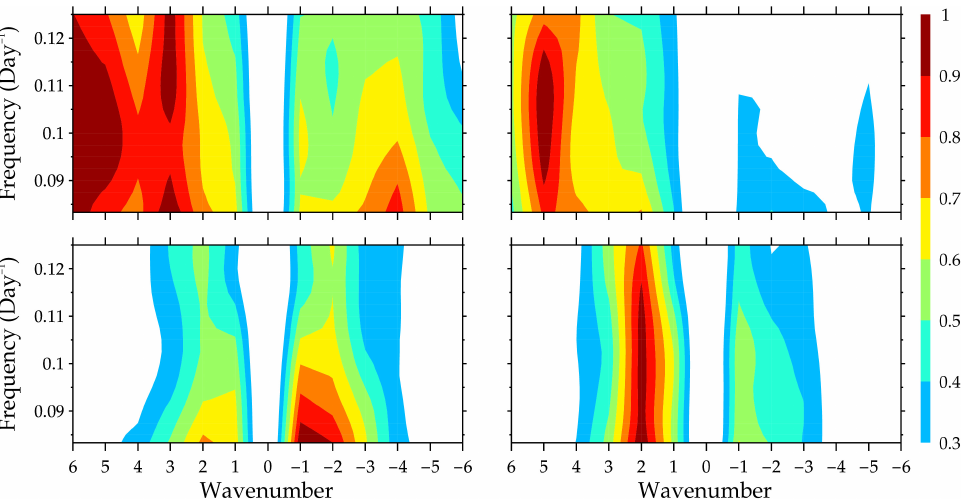
Figure 4. Normalized frequency–wavenumber spectra of the zonal wind disturbances at ∼ 11 km ( top row ) and ∼ 31 km ( bottom row ) along latitudes of 32 ◦ N ( left panels ) and 32 ◦ S ( right panels ) in